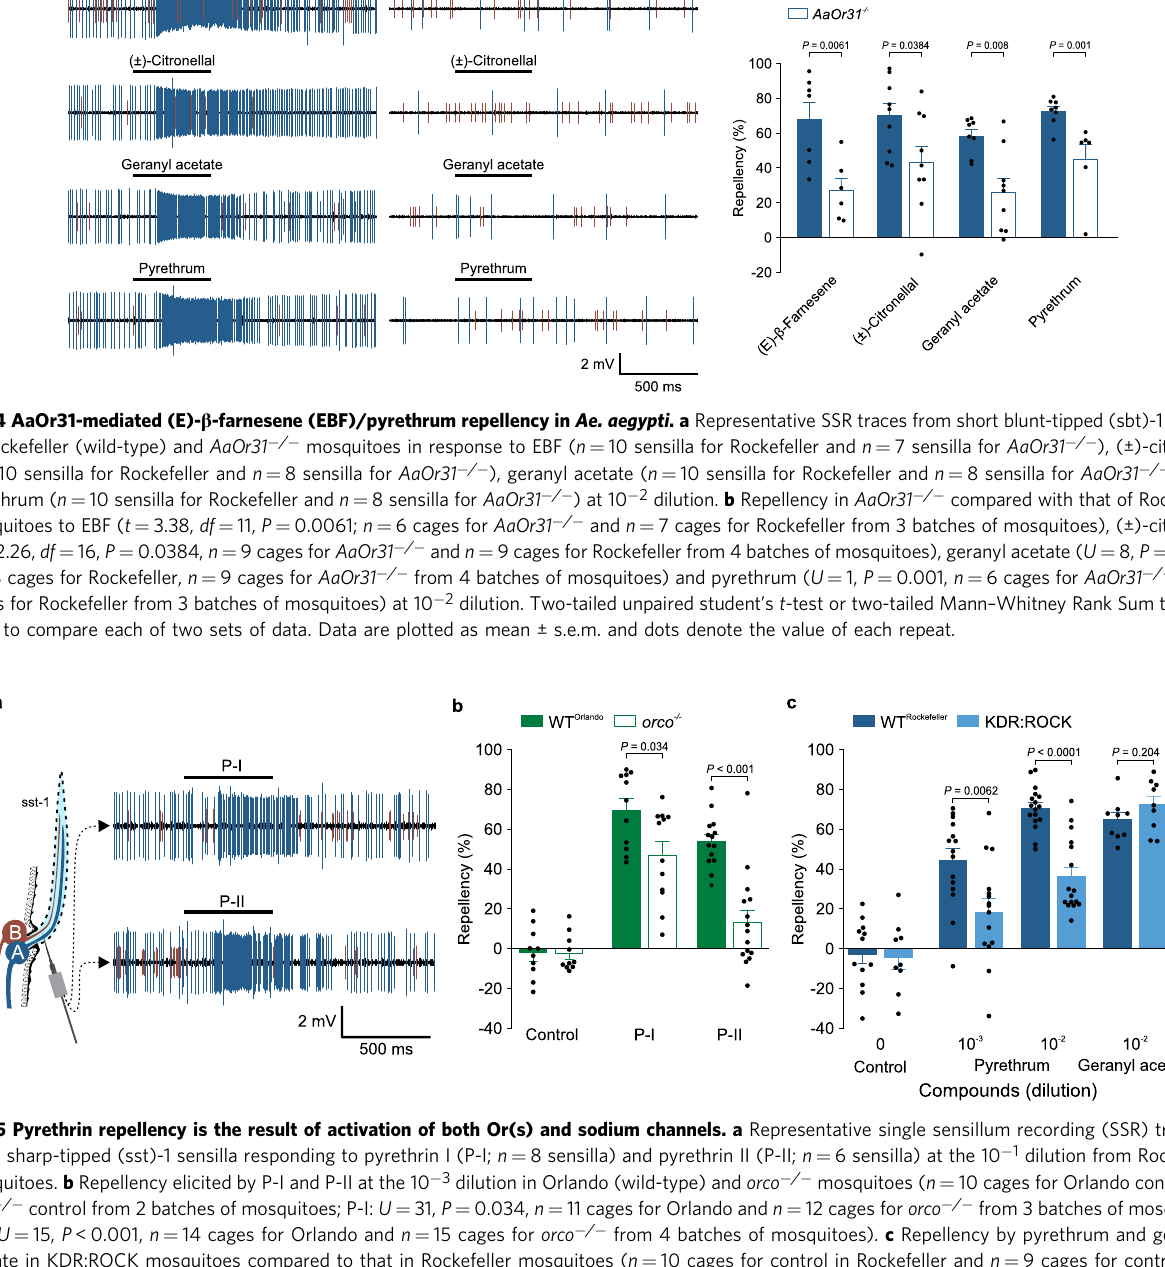
activation of voltage-gated sodium channels.